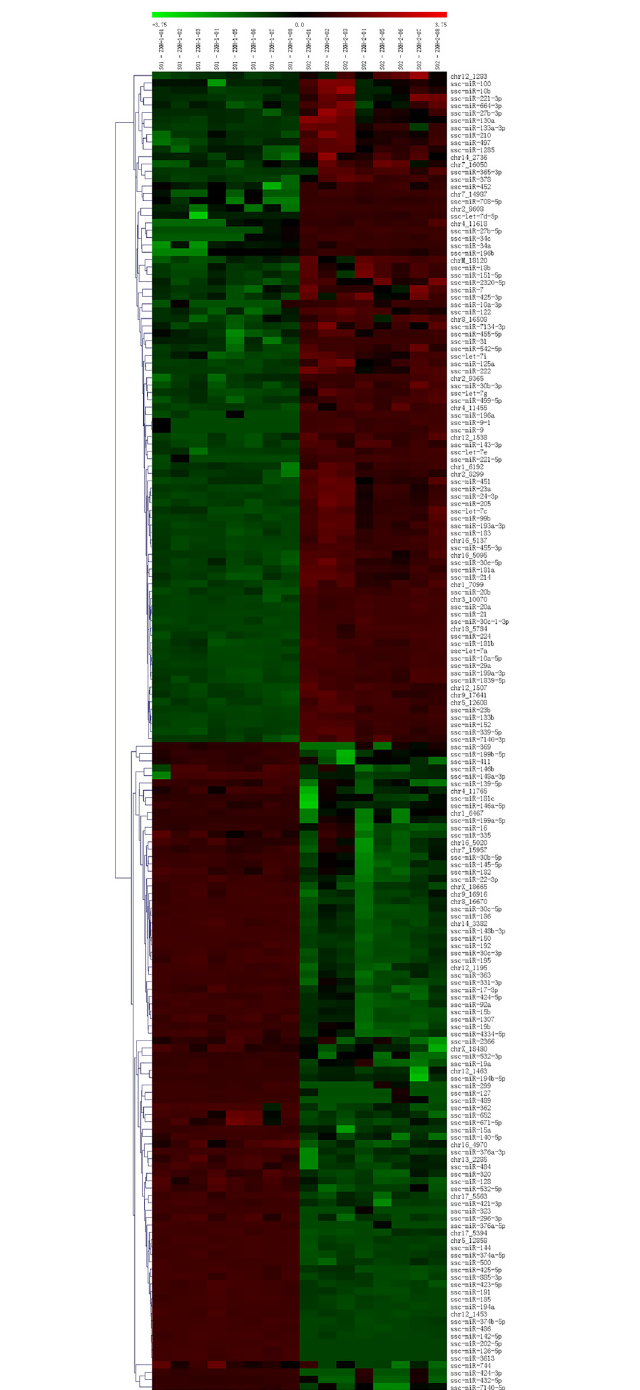
Fig 1. Heatmap of differentially expressed miRNAs in suckling and weaned piglets. Green indicates downregulated expression, and red indicates upregulated expression compared to a reference expression